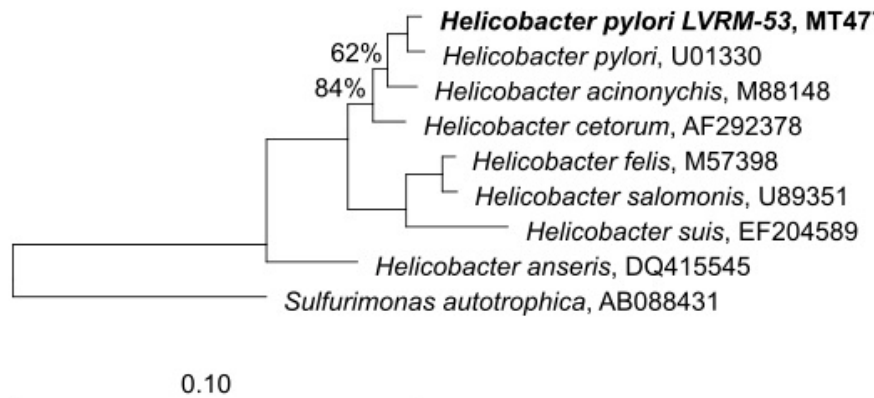
Figure 8. Tree-reconstruction-based on 16S rRNA sequences of LVRM-53 strains, isolated from term pregnant women vaginal yeasts. The tree reconstruction was performed using the neighbor-joining algorithm, implemented in the ARB software package. (GenBank MT477178).